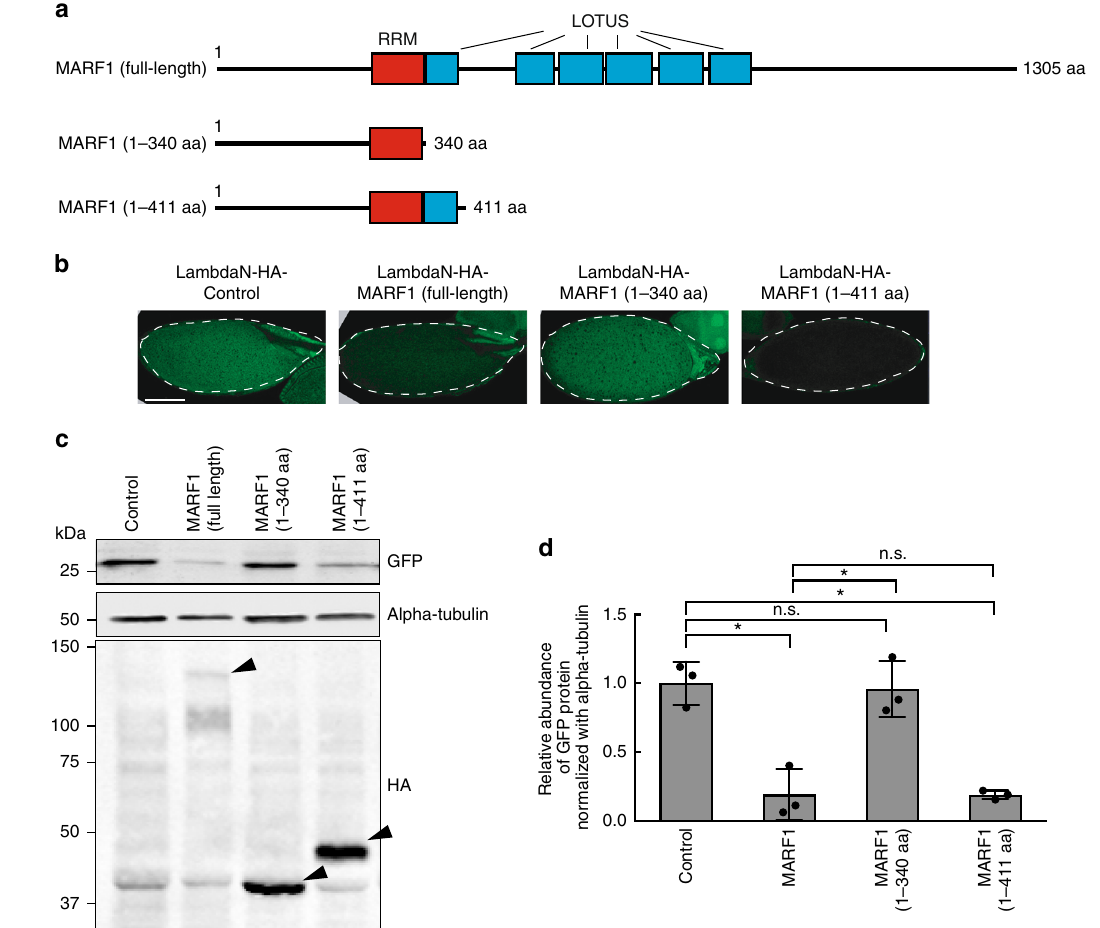
Fig. 8 MARF1 LOTUS domain mediates target silencing. a Full-length MARF1 and MARF1 fragments tested in the GFP-5x BoxB reporter tethering assay. b Confocal images of GFP signal in stage 14 oocytes. Scale bar is 100 μ m. c Western blots using stage 14 oocytes. Black triangles indicate transgenic lambda- HA-fused proteins. d Quanti fi cation of band intensities in d . Mean ±SD ( n = 3). P -value < 0.05 (Student ’ s t -test) is indicated by